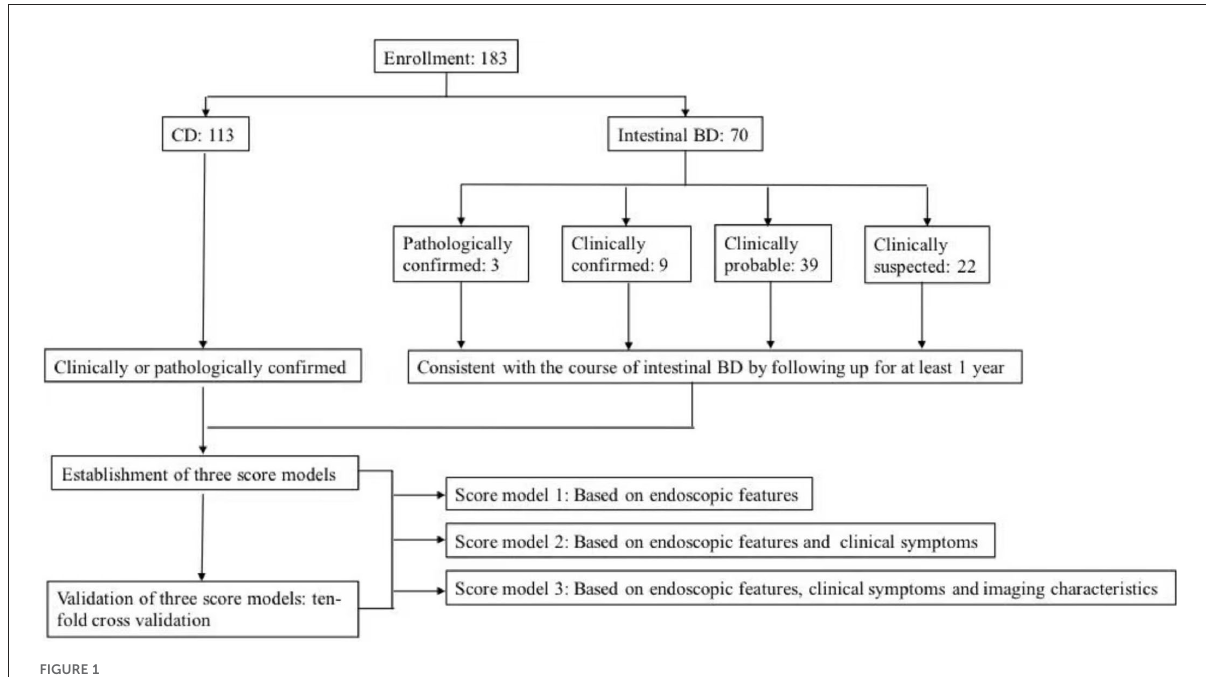
FIGURE1 Flow diagram of patient